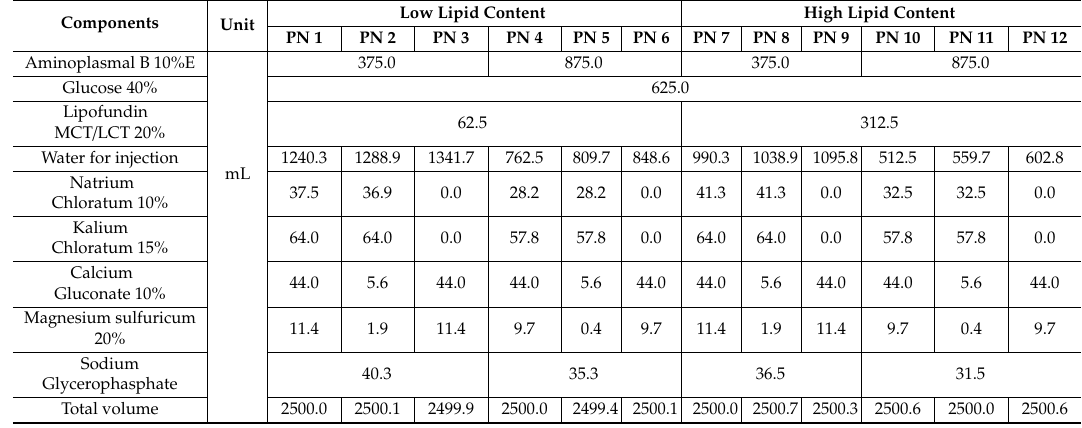
Table 1. Composition of parenteral nutrition admixtures